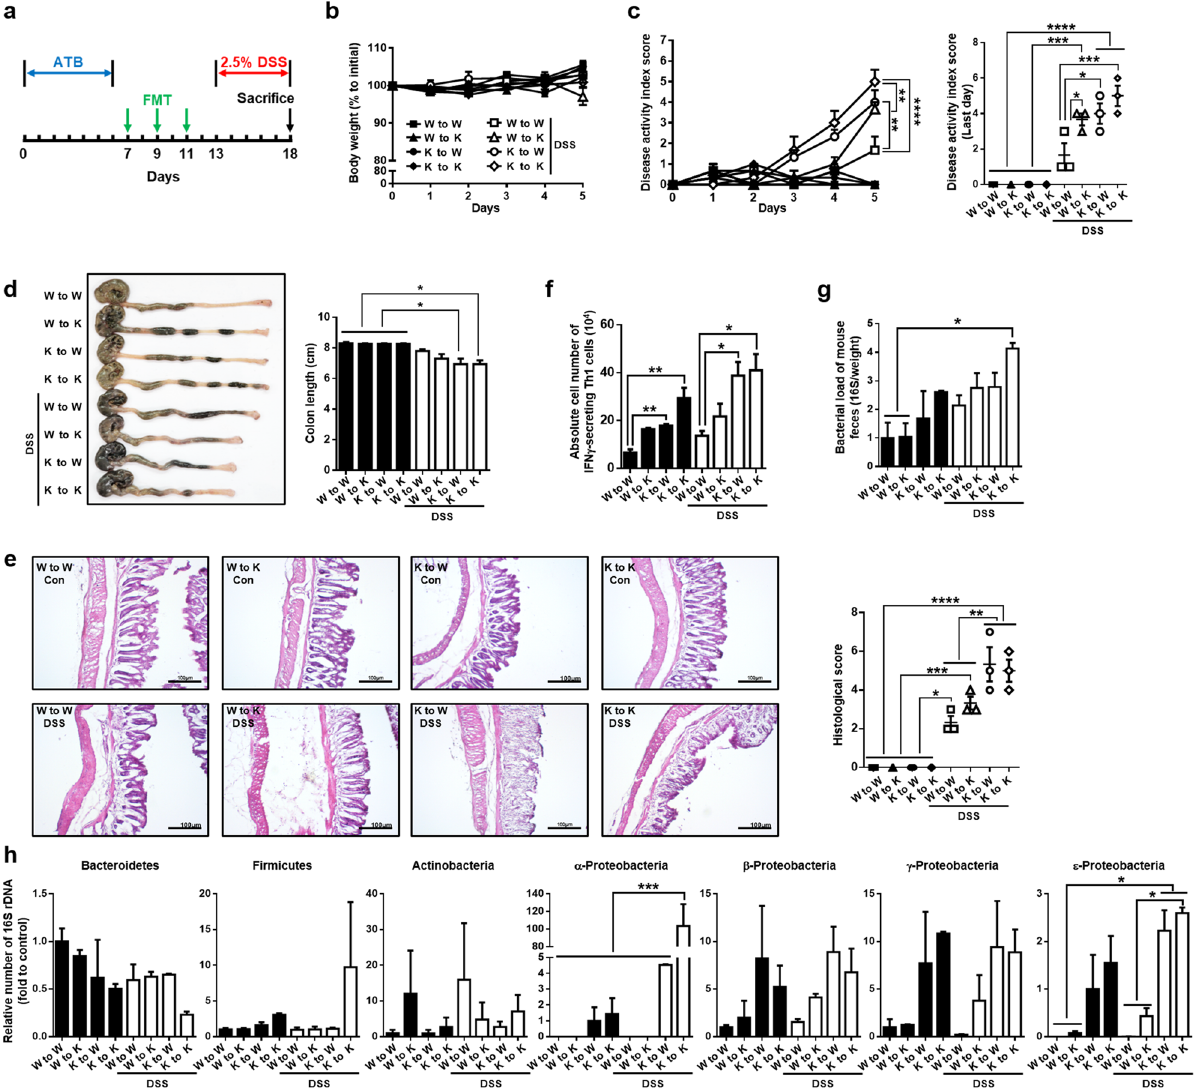
Figure 6. The symptoms of DSS-induced colitis were exacerbated by transfer of feces from Axl −/− mice into WT mice. ( a ) Mice were exposed to antibiotics for 7 days before FMT, and fecal microbiota was transferred 3 times, followed by administration of 2.5% DSS for 5 days before the sacrifice. ( b ) Body weights and ( c ) DAI scores were measured every day during 2.5% of DSS administration for 5 days. ( d ) The macroscopic appearance of the colon (left panel) and the colon length (right panel) was measured on day 5 after DSS administration. ( e ) Representative microscopic images (magnification 200 ×) of colon tissues stained with H&E (left panel) and the histological scores (right panel) were evaluated as described in “Materials and methods”. ( f ) The absolute number of IFNγ-secreting activated Th1 cells was represented as a bar graph. ( g ) The bacterial loads and ( h ) the relative numbers of bacteria were determined as described in “Materials and methods”. Significance (*p < 0.05, **p < 0.01, ***p < 0.001, ****p < 0.0001) was compared with each group and calculated by the one-way ANOVA (n = 3 mice per